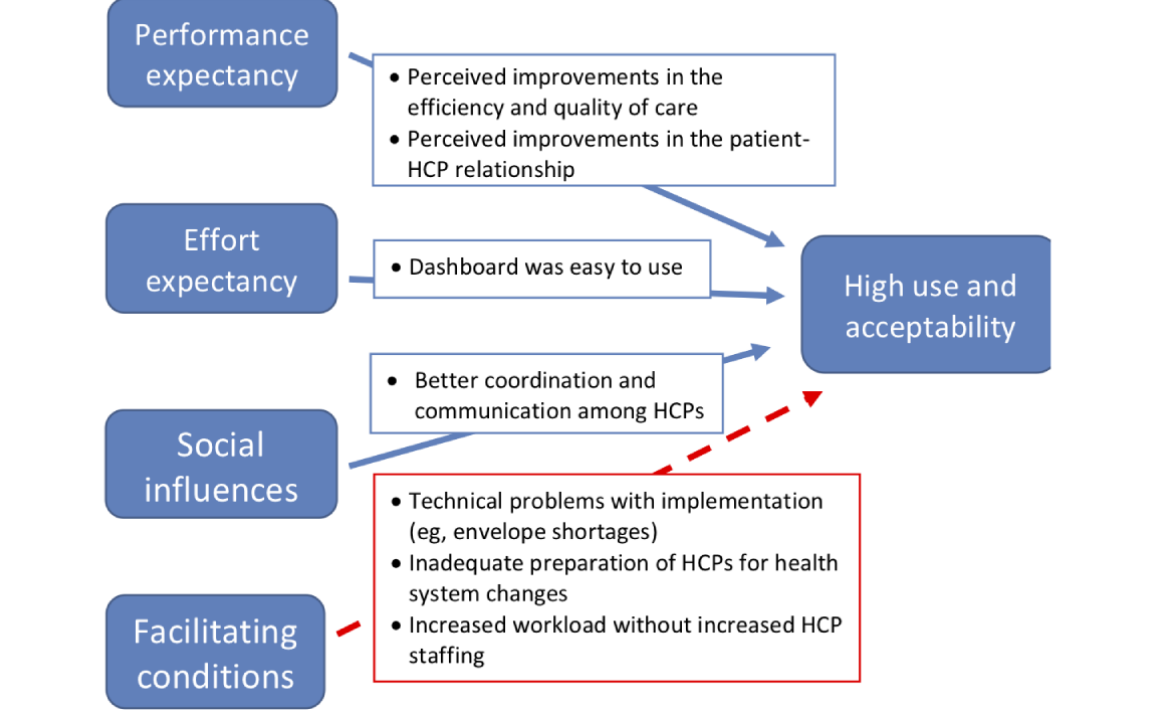
Figure 2. Key findings regarding the determinants of acceptance and use of 99DOTS by health care providers, based on the framework of the Unified Theory of Acceptance and Use of Technology. Most determinants suggest high acceptance, except for facilitating conditions, as indicated by the red dotted line, which indicates a negative association. HCP: health care